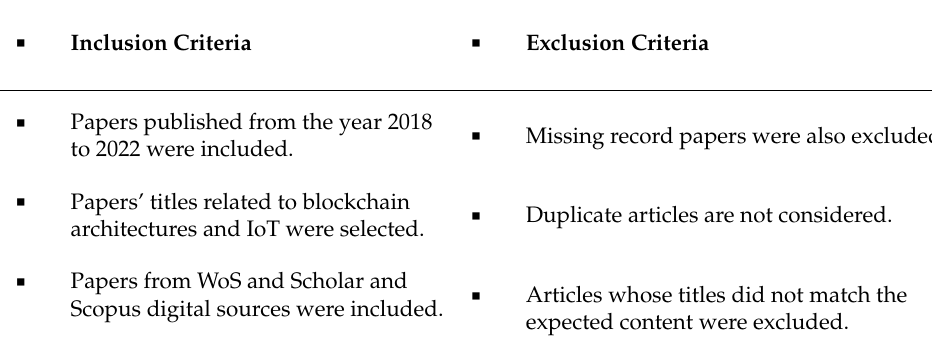
Table 3. Selected Articles.